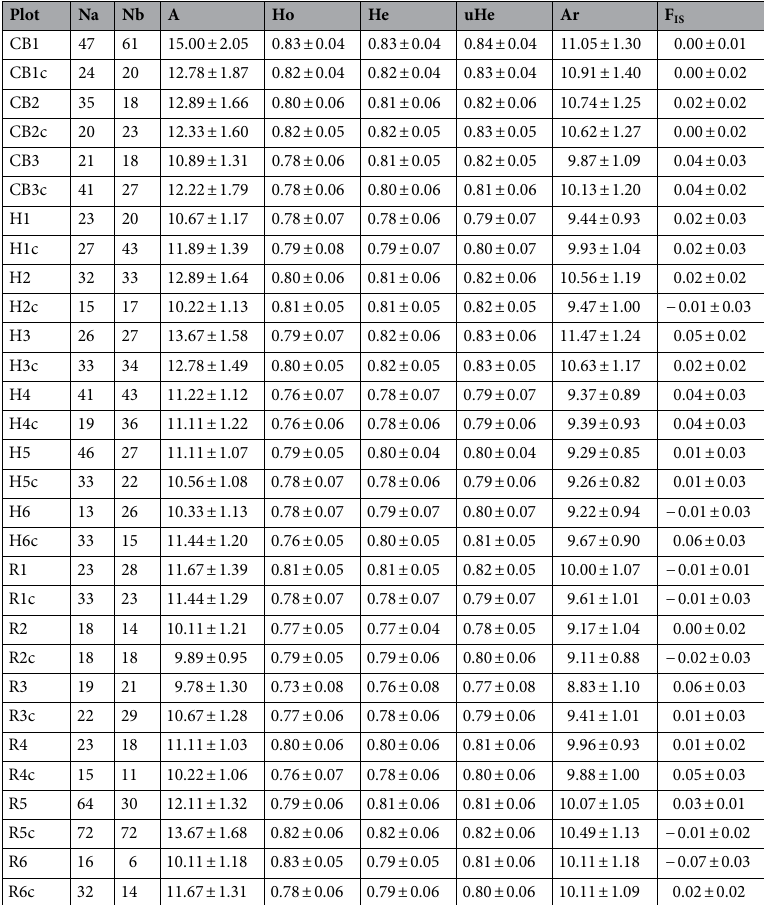
Table 3. Genetic diversity estimates (mean ± se) for the studied populations (experimental and their control plots). Na and Nb represent the number of samples collected at each side of the putative barrier. Average number of alleles per locus (A), observed heterozygosity (Ho), expected heterozygosity (He), unbiased expected heterozygosity (uHe), allelic richness (Ar), average inbreeding coefficient within individuals (F IS